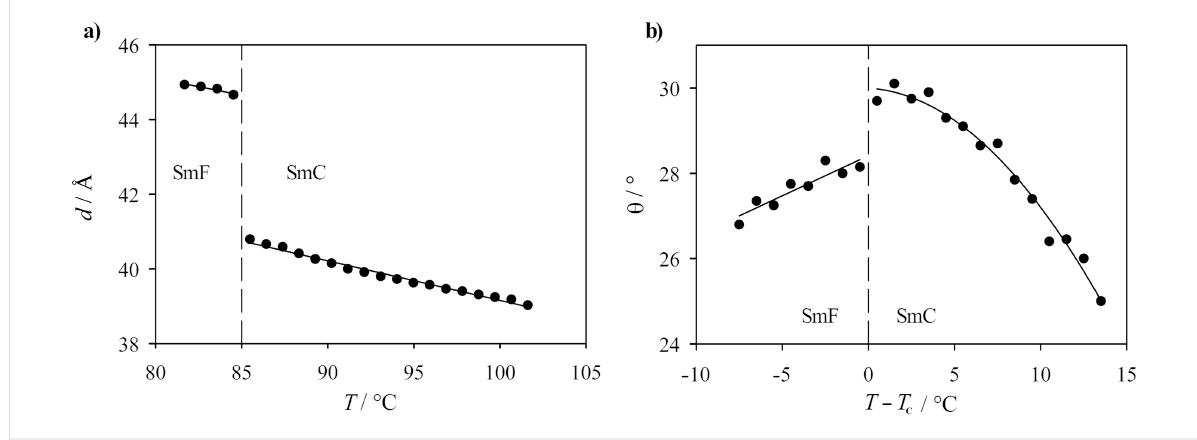
Figure 12: (a) Layer spacing of the SmF and the SmC phase of the pure compound PhP16 in dependence of the temperature T . (b) Tilt angle θ versus reduced temperature T − T c for the pure compound PhP16 in the SmF and in the SmC phase.